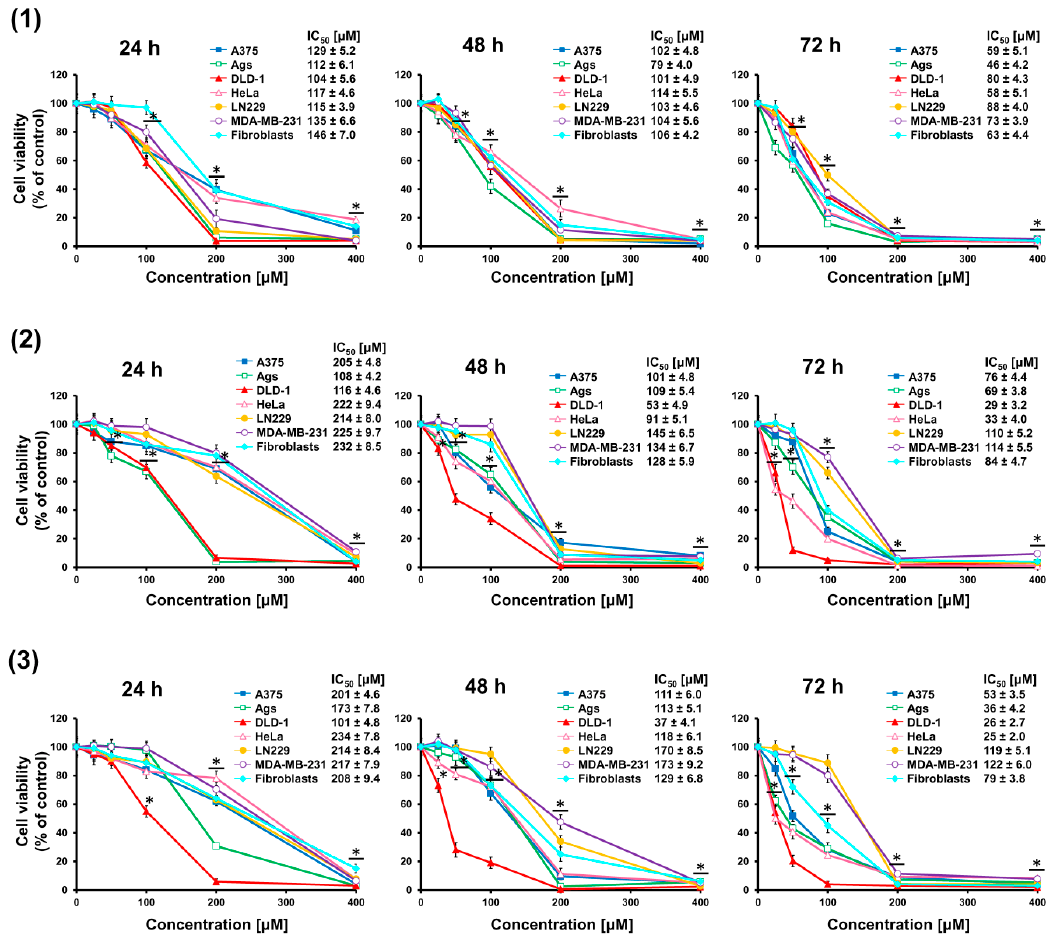
Figure 2. Triterpene seco -acids decrease cell viability. Effect of 3,4- seco -urs-4(23),20(30)-dien-3-oic acid ( 1 ), 3,4- seco -olean-4(24)-en-19-oxo-3-oic acid ( 2 ), and 3,4- seco -urs-4(23),20(30)-dien-19-ol-3-oic acid ( 3 ) on the viability of cancer cells A375, AGS, DLD-1, HeLa, LN229, MD-MB-231 and normal dermal fibroblasts after 24, 48, and 72 h treatment, as assessed by MTT assay. Data are presented as mean ± standard error of the mean (SEM) from three independent experiments. * p < 0.05 compared to control group. The half-maximal inhibitory concentration (IC 50 ) values of seco -acids for the cell lines are shown. Table 1. IC 50 values ( μ M) of compounds 2 and 3 for fibroblasts and selected cancer cell lines after 48 and 72 h of treatment.